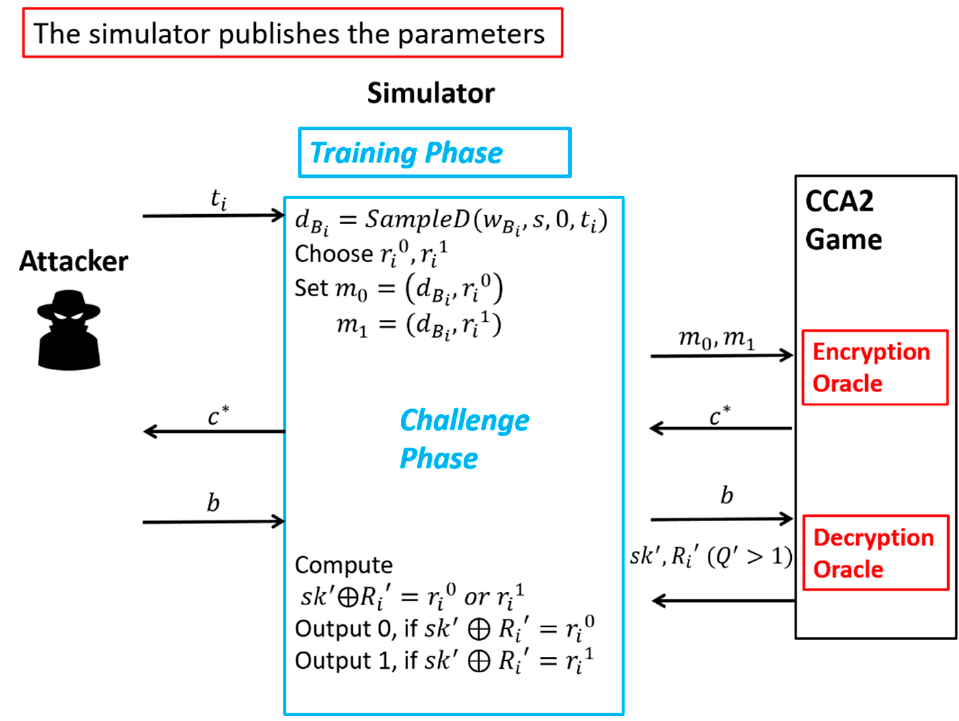
Figure A3. The authenticity of the manager ( Q (cid:48) > 1 )